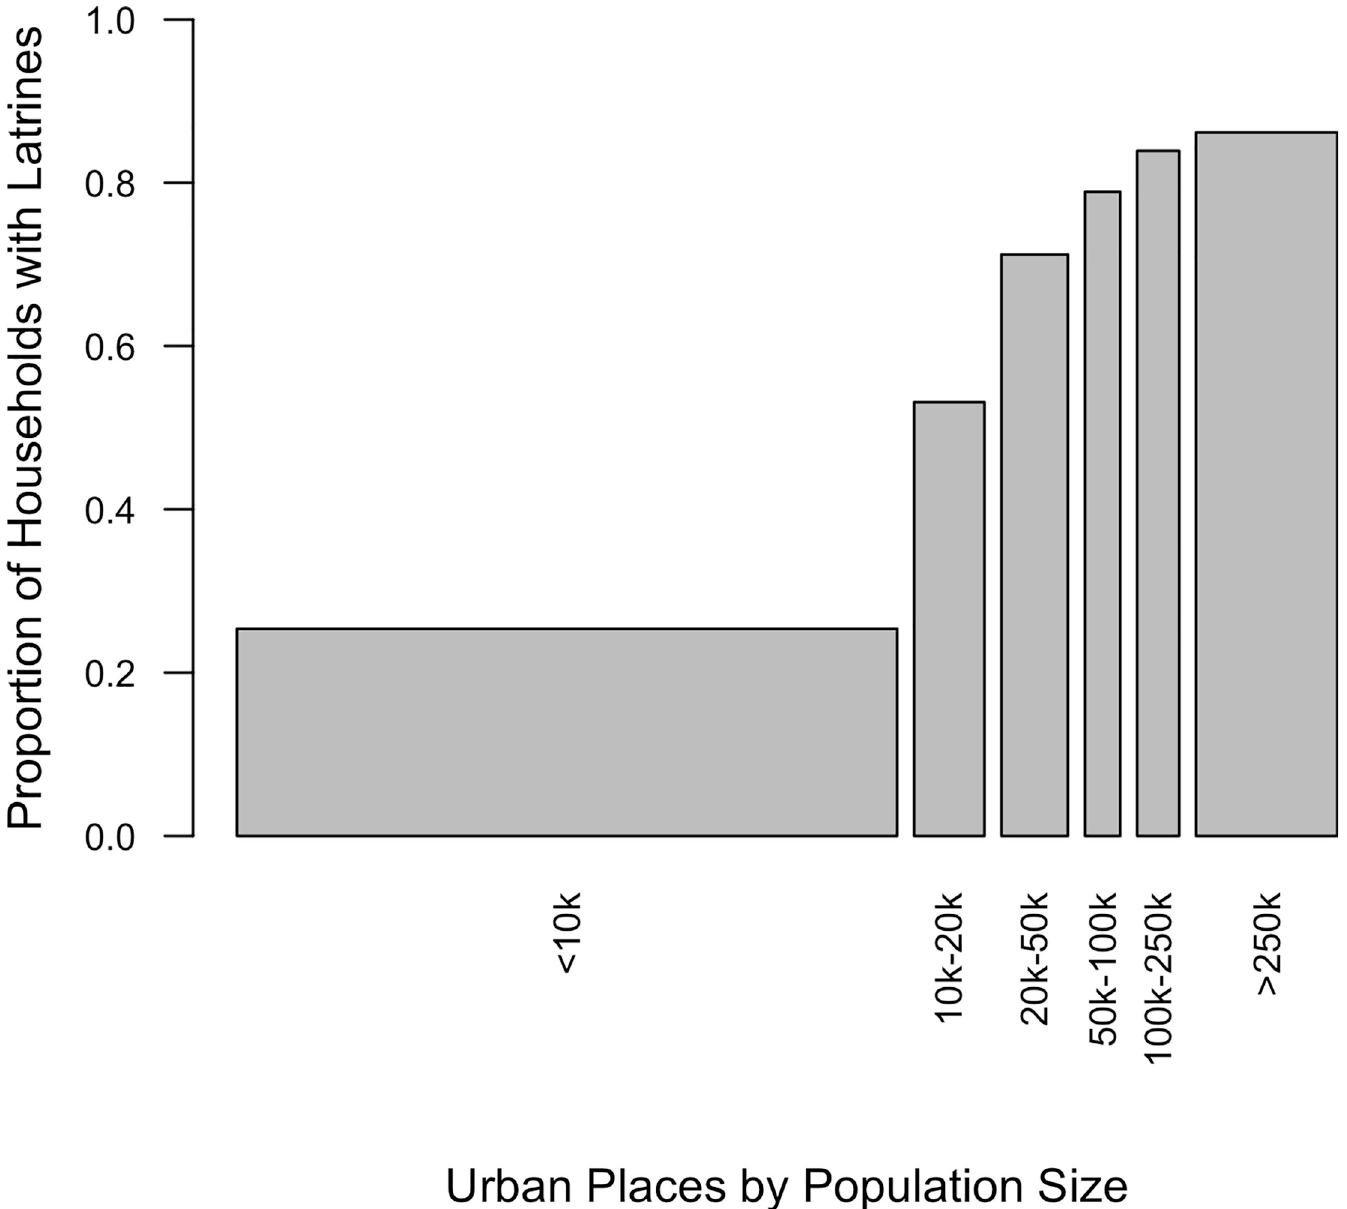
Fig 1. Household latrine coverage in urban India by population size. Bar widths correspond to proportion of urban population located in each place category. Data: 2011 Indian Census. Urban places include outgrowth areas.